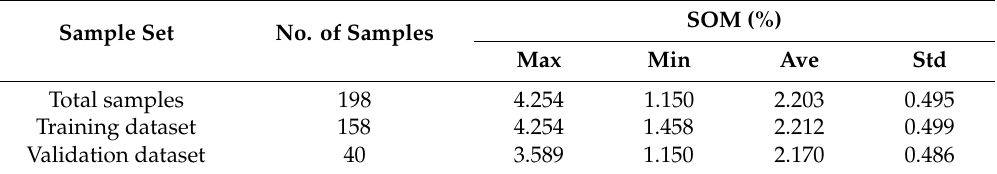
Table 1. Descriptive Statistics of Various Sample sets.